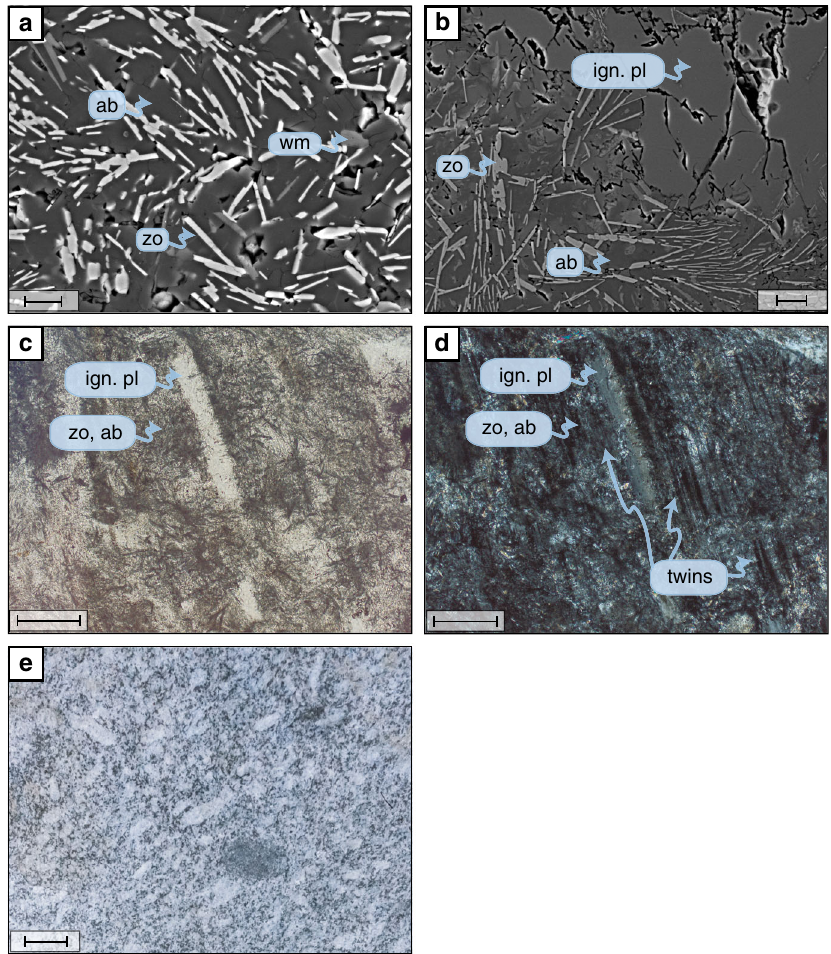
Fig. 3 Microphotographs of high-pressure plagioclase pseudomorphs and outcrop picture of an undeformed metagranite. a Backscattered electron image of pseudomorphic replacement of the igneous plagioclase by fi ne-grained assemblage of albite, zoisite, and white mica. b In some places, the igneous plagioclase is partially preserved. Mineral abbreviations are as follows: ab = albite; ign. pl = igneous plagioclase; wm = white mica; zo = zoisite. c Plane- polarised light microphotograph of a thin section showing plagioclase pseudomorphs (ab and zo: dark fi ne-grained crystals) partially replacing igneous plagioclase. d Same area as c , under crossed polarisers. Note that the matrix albite in the fi ne-grained replacement texture has inherited the crystallographic orientation as evidenced by the twin planes. This con fi rms direct replacement of igneous plagioclase by the albite, con fi rming that jadeite never formed. e Picture of a typical undeformed metagranite with large K-feldspars in a matrix of plagioclase, quartz, and biotite. Scale bars are a 10 µ m; b 20 µ m; c 200 µ m; d 200 µ m; e 5